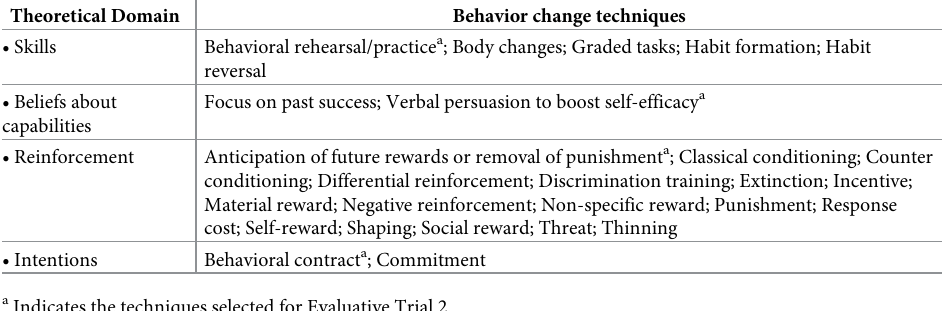
Table 7. Links between the identified Theoretical domains and the behavior change